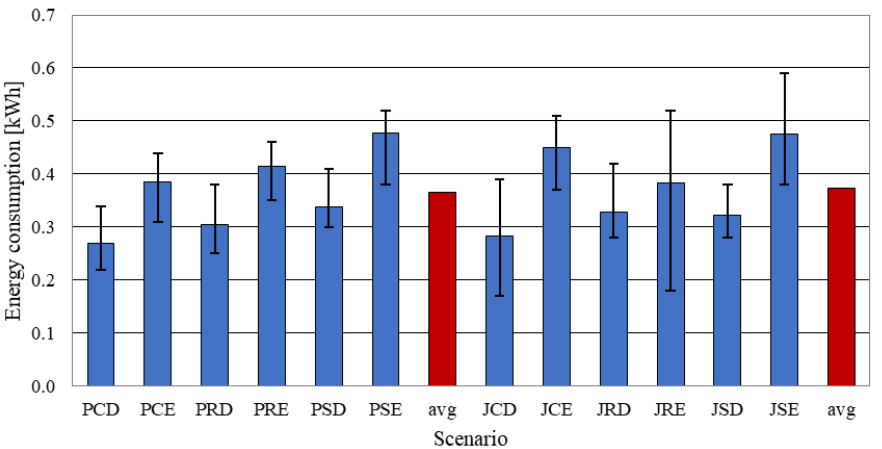
Figure 8. Energy consumption depending on the airplane propulsion selected in the simulation.